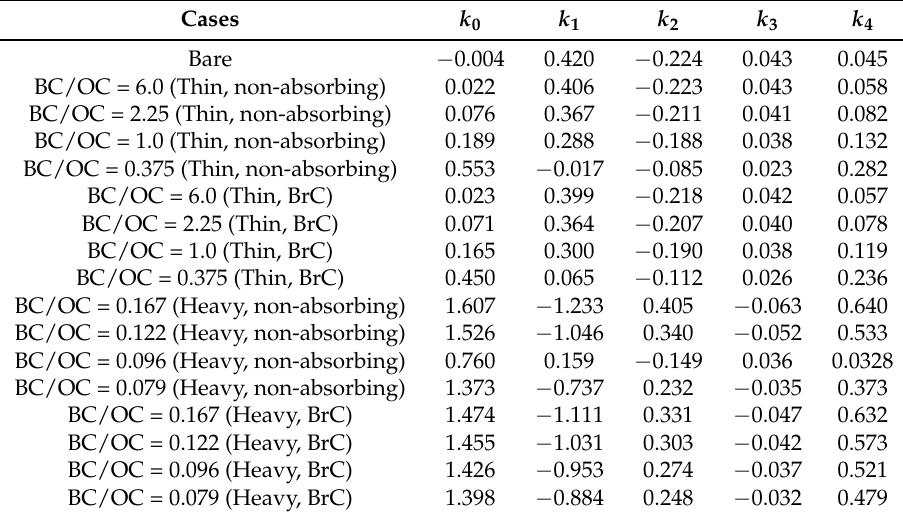
Table A3. Fitting parameters of BC aerosols for SSA (532 nm).